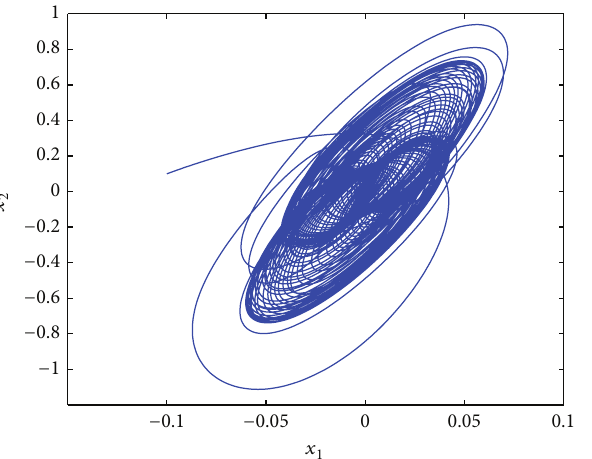
Figure 1: The chaotic behavior of master system (1).